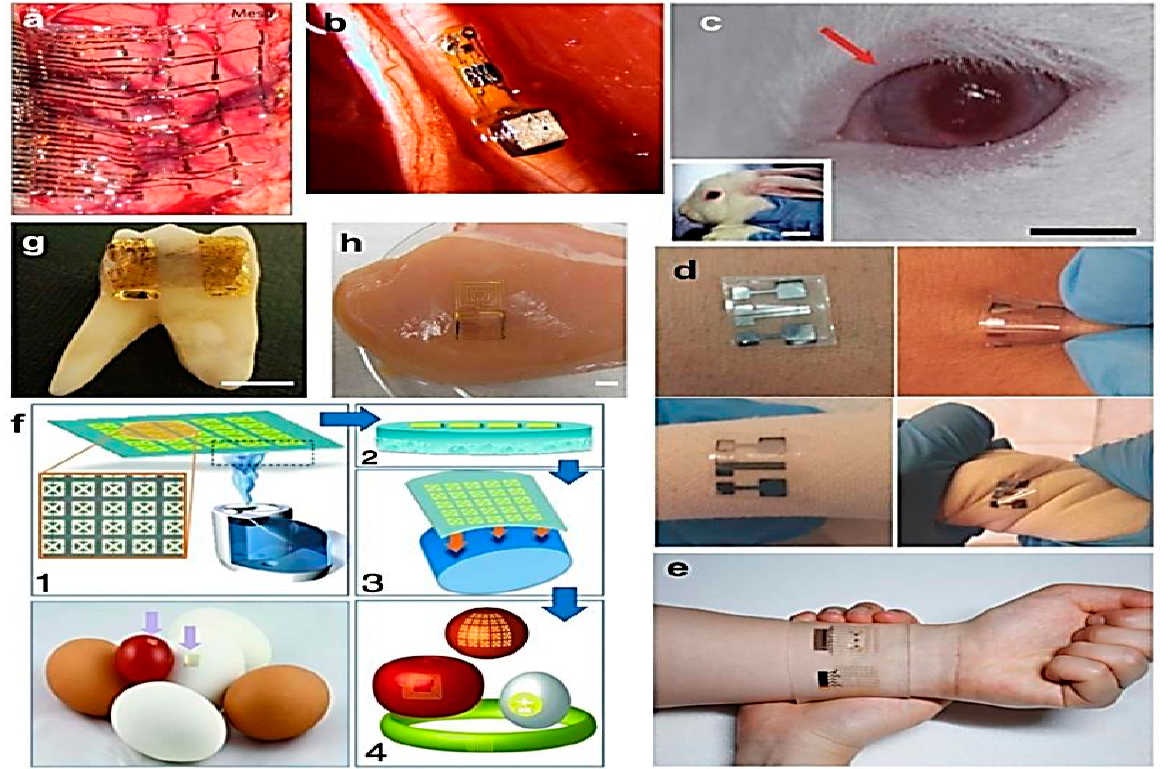
Figure 9. The possible locations where a flexible bio-patch nanosensor can be used [142]. ( a ) Image of fabricated sensor; the sensor can be attached to the surface of the meat or be placed onto the inside lining of the package. The status of the meat product can be monitored using smart phone by taking a photo of the sensor. ( b ) Schematic representation of self-powered multifunctional electronic skin used for continuous monitoring of lactate, glucose, uric acid, and urea in exercise-induced sweat using piezoelectric-linked enzymatic biosensors. During exercise, this device functions without an additional power supply through piezoelectric–enzymatic reaction coupling. ( c ) A wireless glucose sensor incorporated into a contact lens platform with wireless power transfer circuitry and display pixels for a fully integrated and transparent platform that does not hinder vision. This device detects fluctuating tear glucose concentrations through a resistance-based enzymatic mechanism demonstrated in a rabbit model. ( d ) Epidermal reverse iontophoretic tattoo-based glucose sensor configuration and operation principle, with picture of device applied to a human subject. Proof-of-concept demonstration of reverse iontophoretic tattoo-based ISF glucose sensor. This indicates aa working electrode and reference/counter electrode, respectively. ( e ) Iontophoretic paper battery and skin-like biosensor for noninvasive blood glucose monitoring, applied to a human subject. The inclusion of hyaluronic acid, facilitates enhanced ISF extraction for increased ISF glucose sampling reliability. ( f ) Schematic of steps for rapid transfer of silk antennas onto curved substrates: (1) Water vapor is applied to the back of silk films, yielding (2) a film in which the back surface of the film has been partially melted. (3) This melted surface is conformally applied to arbitrary surfaces, yielding (4) applied functional sensors on various surfaces. Photos of THz split-ring resonators (SRRs) fabricated on the silk substrate wrapped on an apple. ( g ) Mouthguard-based sensor for glucose monitoring in saliva with on-body application and analysis of increasing glucose concentrations. Fully integrated saliva glucose sensor aims toward continuous in-mouth glucose monitoring. ( h ) Various demonstrations of biosensors in the food industry. ( a ) Geometric barcode sensor for monitoring chicken spoilage under different temperature conditions.